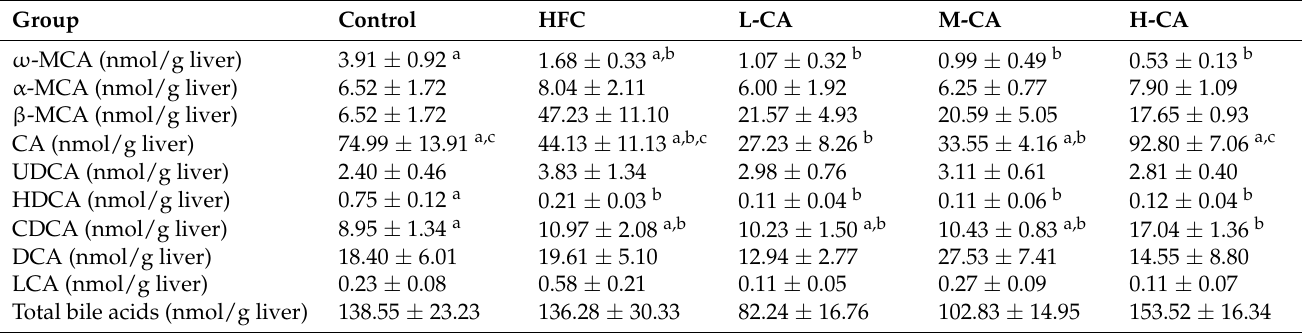
Table 4. Hepatic bile acids profile in Sprague–Dawley rats fed the normal, HFC, and CA- supplemented HFC diet for 9